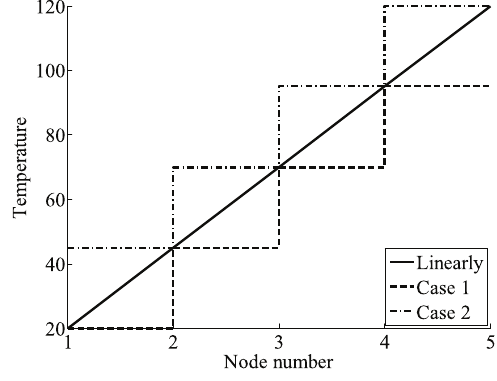
Fig. 11. The three treatments of axial temperature distribution.